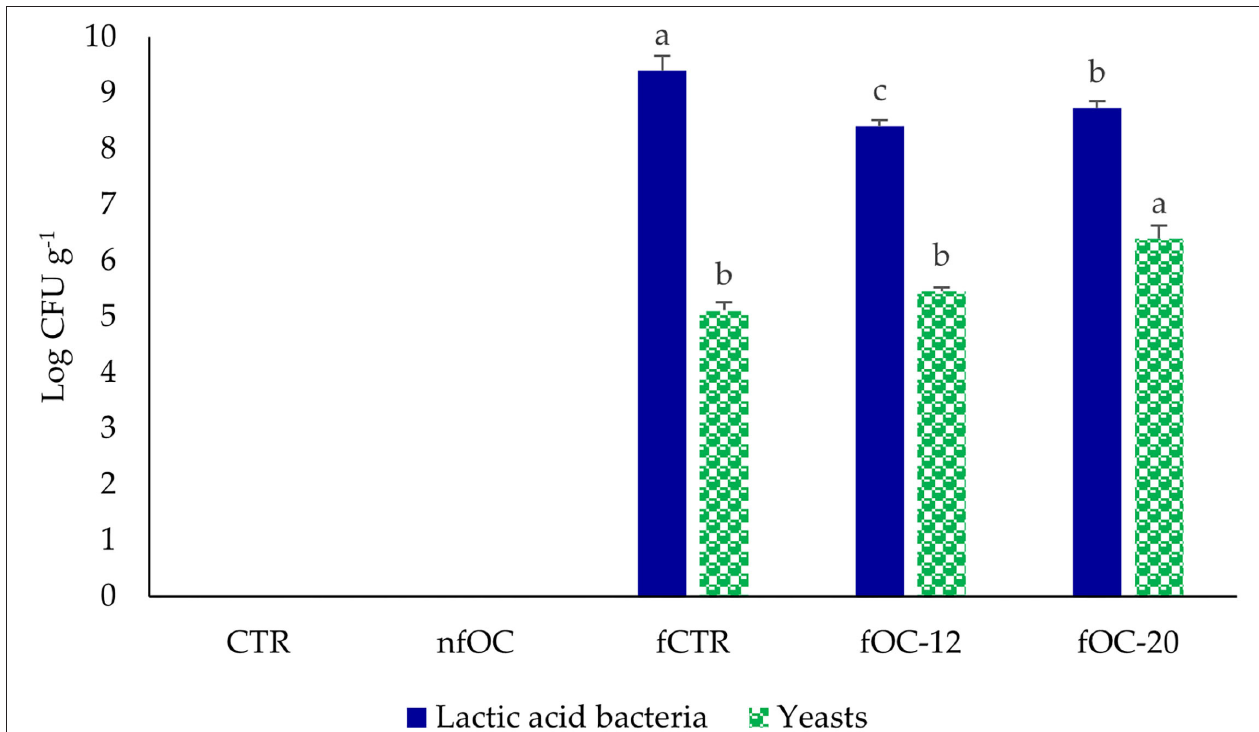
FIGURE 2 | Cell density (log CFU g − 1 ) of presumptive lactic acid bacteria and yeasts in gluten-free breadstick doughs. CTR, control breadsticks obtained by the dough without OC addition and without microbial fermentation; fCTR, breadsticks obtained by the dough without OC addition and fermented; nfOC, breadsticks obtained by the dough supplementation with 1% OC without microbial fermentation; fOC-12, breadsticks obtained by the dough supplementation with 1% OC and fermented for 12h; fOC-20, breadsticks obtained by the dough supplementation with 1% OC and fermented for 20h. The values represent means of triplicates; different letters indicate significant differences ( p < 0.05) according to Tukey’s Honestly Significant Difference (HSD) test.